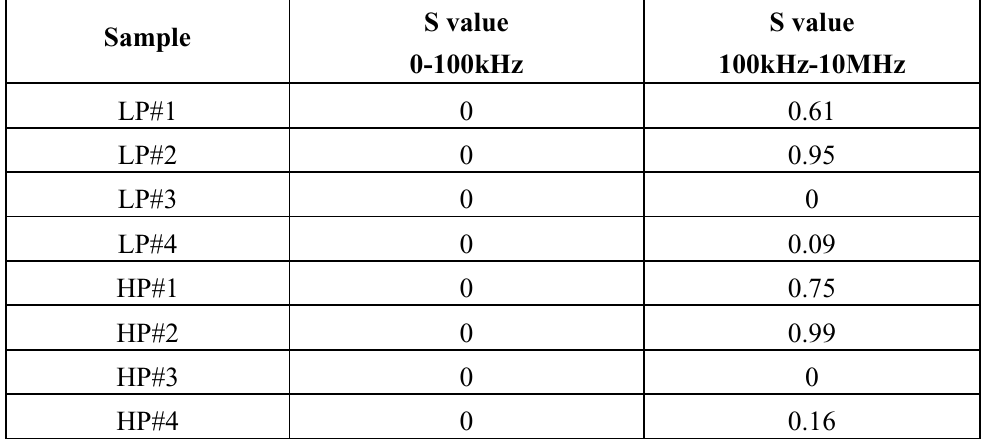
Figure 4. The variation of conductance against frequency for the In at high vacuum pressure. Table 2. The s values obtained from log conductance versus log